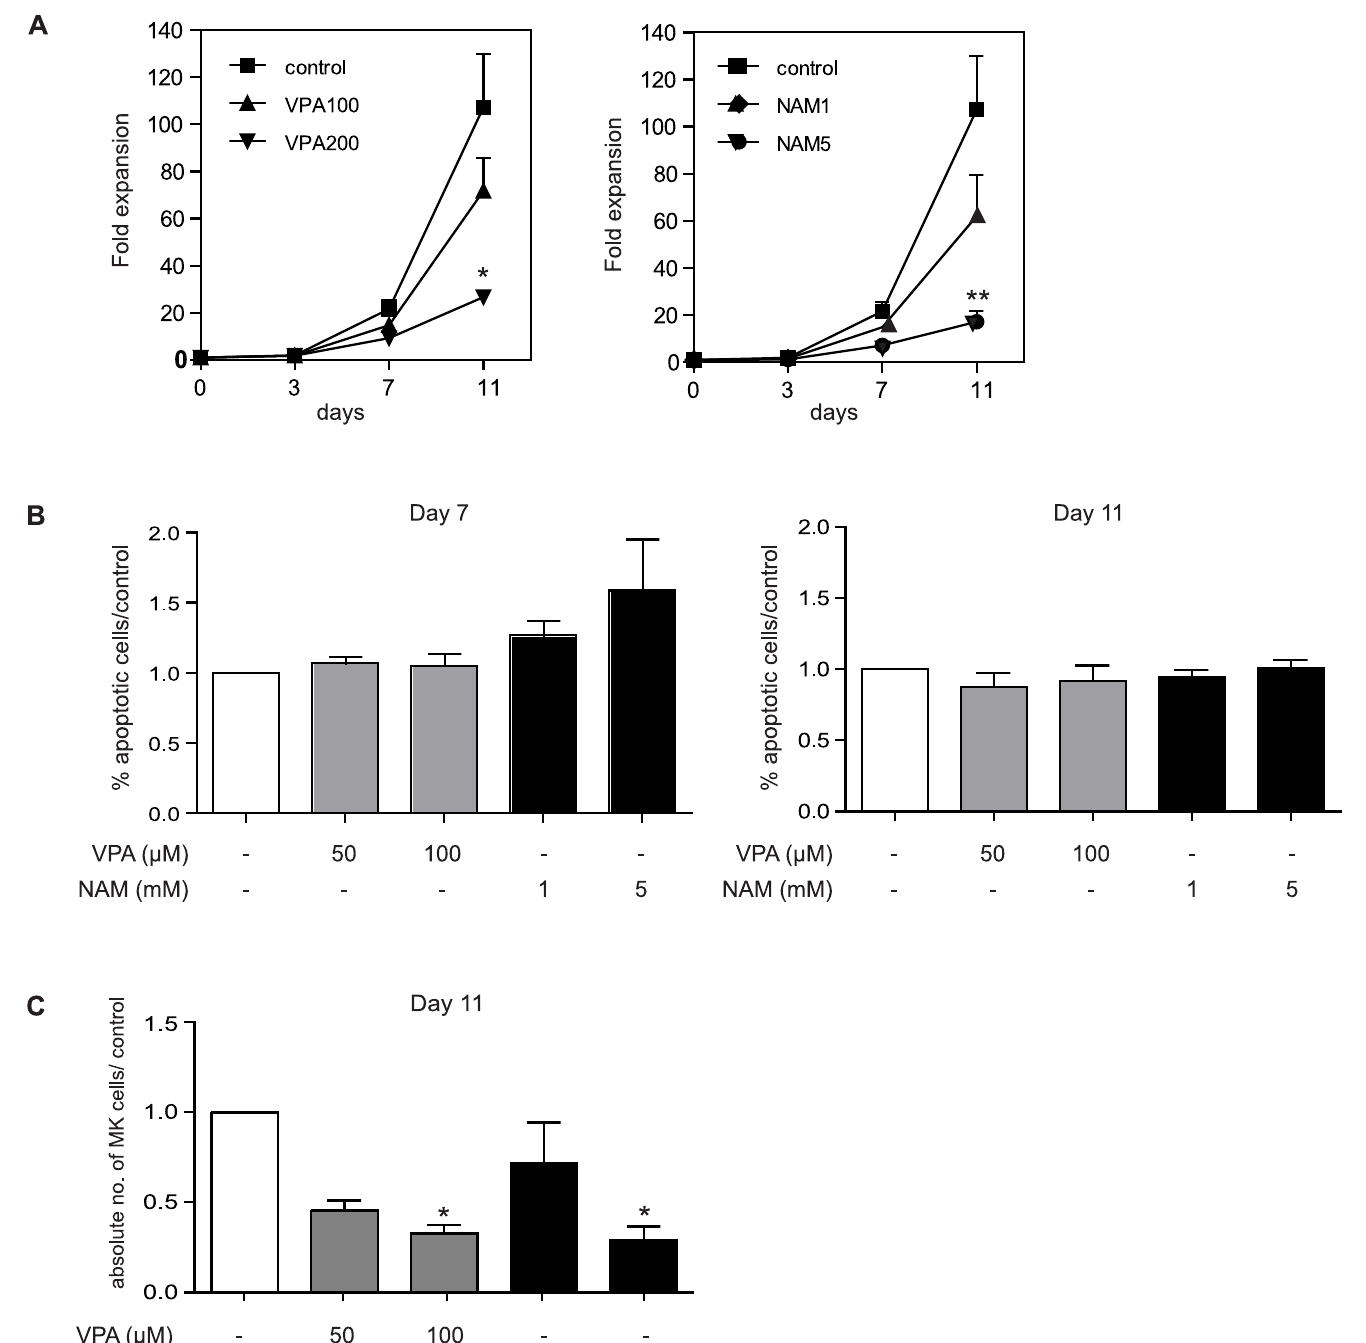
Fig 3. VPA and NAM treatment inhibits megakaryocyte progenitor proliferation. UCB-derived CD34+ cells were differentiated towards megakaryocytes for 11 days in the absence or presence of 100–200μM VPA, or 1-5mM NAM. (A) At all culture time points, trypan blue negative cells were counted. Data represent the fold expansion of megakaryocyte precursors during development. (B) At day 7 and 11, the percentage of apoptotic cells was determined by FACS. Data represent the percentage of Annexin V-positive cells, compared to the control. (C) Absolute numbers of CD61/CD42b positive megakaryocytes were calculated after 11 days of differentiation. Data are representative for 4 independent experiments. Error bars represent SEM, (cid:3) p < 0.05, (cid:3)(cid:3) p < 0.01.